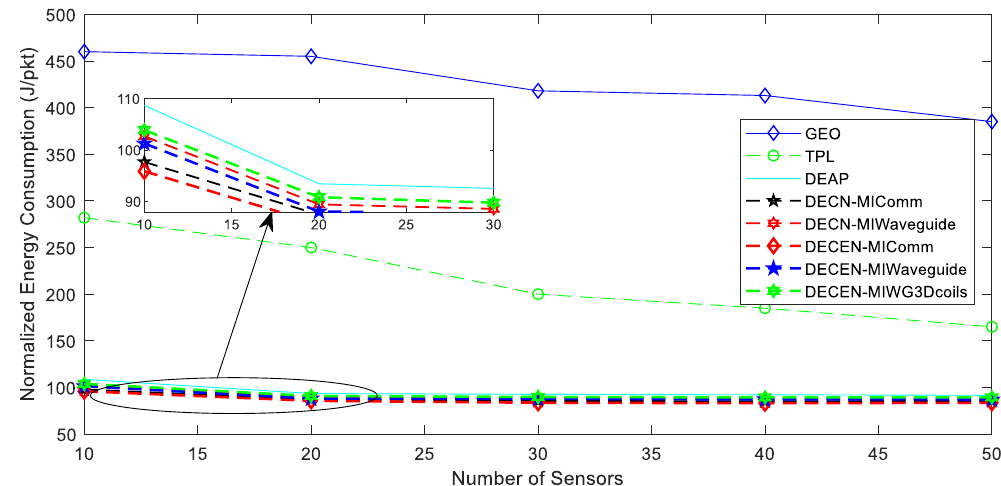
Figure 9. Comparison graph for energy consumption with the varying number of sensors.